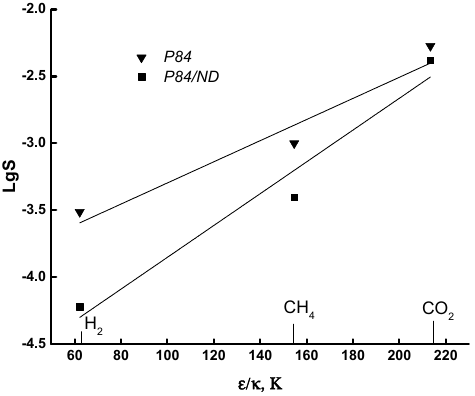
Figure 5. Dependence of solubility coefficients on the depth of the Lennard-Jones potential of gases for P84 and P84/ND membranes.